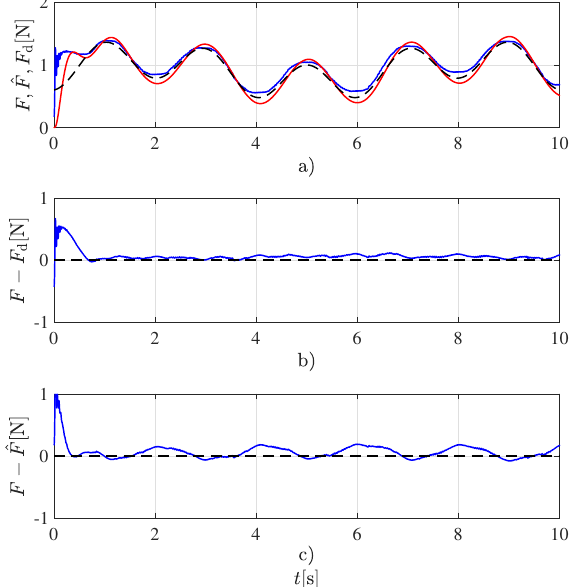
Figure 2. Force tracking and estimation for the Ecoflex 00-50 sample. ( a ) Forces: desired (- - -), measured (—), and estimated (—). ( b ) Force tracking error. ( c ) Force estimation error. The corresponding position of the robot’s tip in the vertical direction ( z 0 -axis in robot base-coordinates) is displayed in Figure 3. Approximately the first second of the experiment corresponds to the transient response of the closed-loop controller and observer; therefore, it is discarded for the parameters estimator